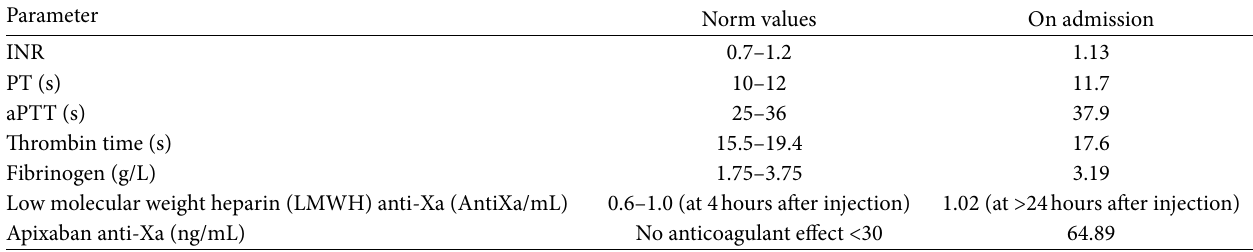
Table 1: Coagulation tests on emergency department admission.